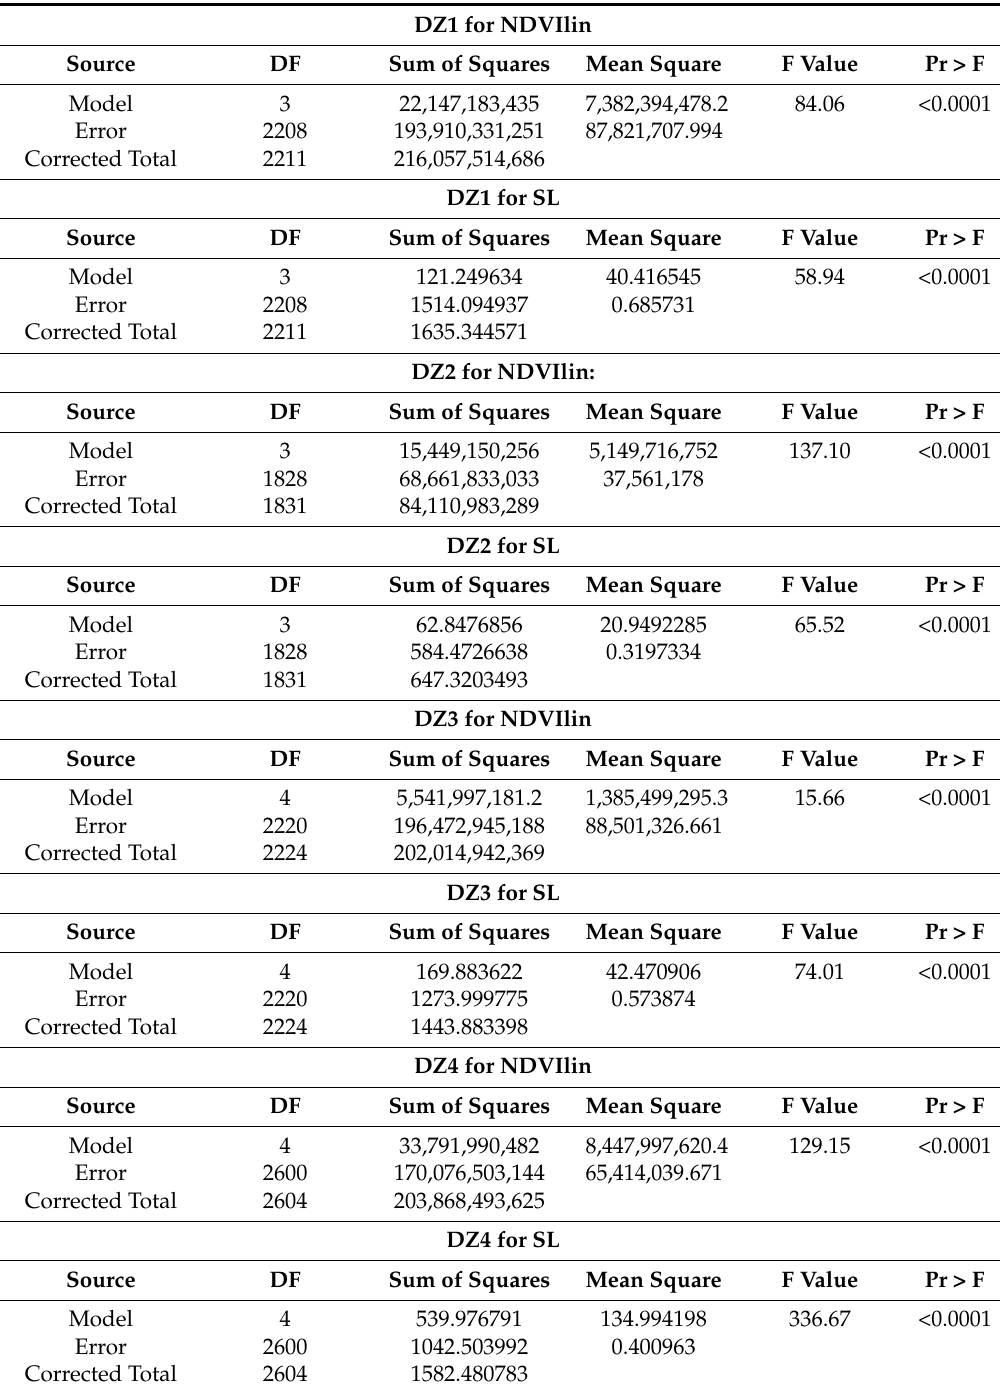
Table A1. The ANOVA outputs of Section